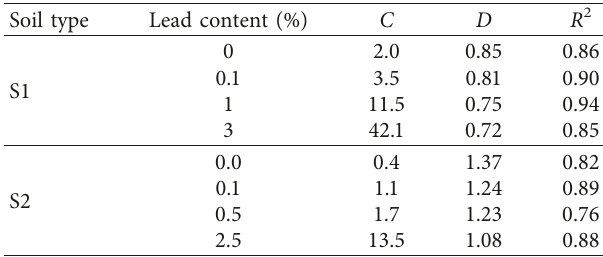
Table 3: Empirical constants between unconfined compressive strength and electrical